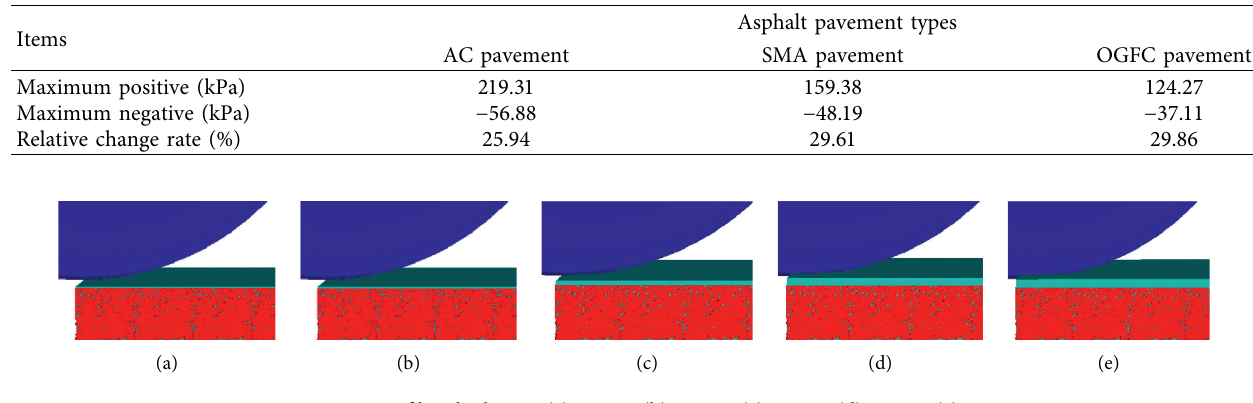
Figure 11: Water film thickness: (a) 1mm; (b) 2 mm; (c) 5mm; (d) 8 mm; (e) 10mm.